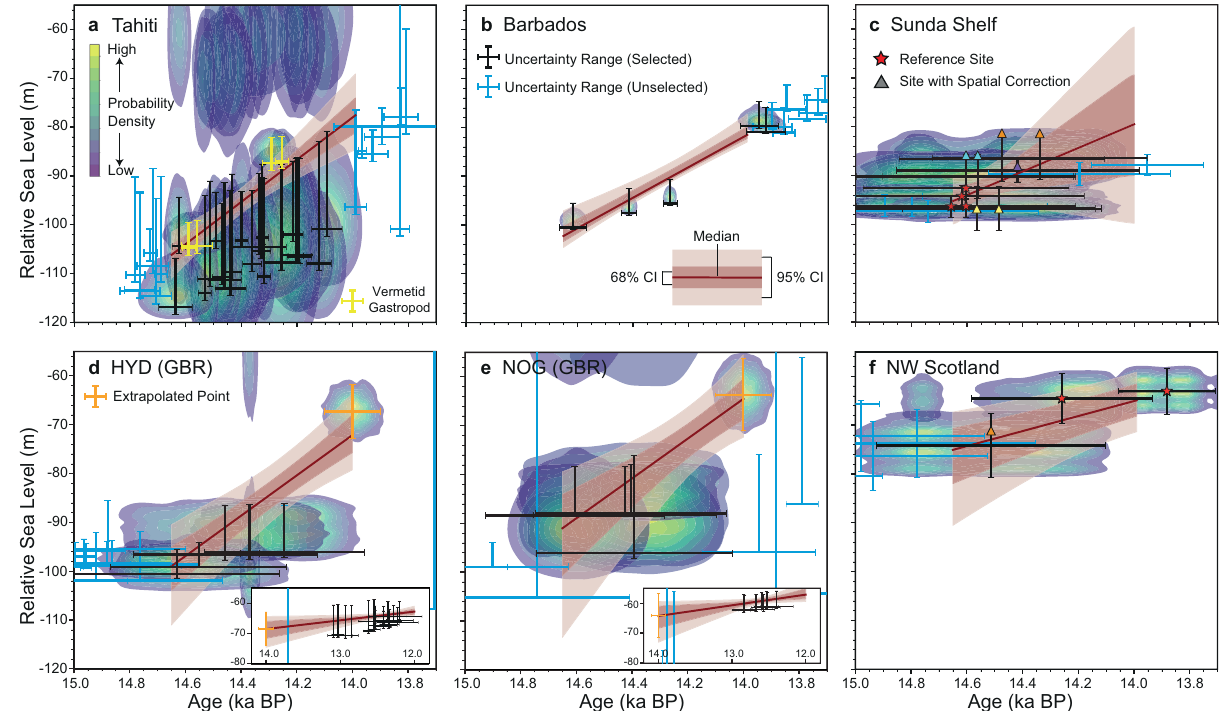
Fig. 2 Estimated local MWP-1A sea-level rise trend at six selected sites using our empirical scenario. Blue-green-yellow shading indicates the data- point-speci fi c probability density accounting for age and depth uncertainties. The depth uncertainty for coral-based SLIPs ( a , b , d , e ) was determined using modern ecological data (the empirical scenario), some of which present a bimodal habitat depth, resulting in complex data clouds. For the uniform scenario, see Supplementary Fig. 6. The median and 95/68% con fi dence interval (CI) were determined by 20,000 MC simulations (see main text). Black/blue error bars re fl ect uncertainty ranges associated with viscous and spatial signal corrections applied to SLIPs that were selected/unselected to train the MC model. Vertical and horizontal bars indicate combined depth uncertainty and 2 σ age error. a The selected coral samples containing vermetid gastropods are highlighted in yellow. c , f A spatial sea-level gradient correction was applied to ensure all SLIPs represent sea level at a single locality (reference site, denoted by red stars) in Sunda Shelf and Northwest Scotland. Triangles with different colours correspond to different localities, their vertical position indicates the original elevation prior to spatial gradient correction. d , e Orange error bars indicate the extrapolated point, the extrapolation process is shown in the subplot. f SLIPs have been corrected for the local GIA signal using the BRITICE-CHRONO ice model with 120 Earth models. GIA modelling uncertainty is incorporated into the error bars and data